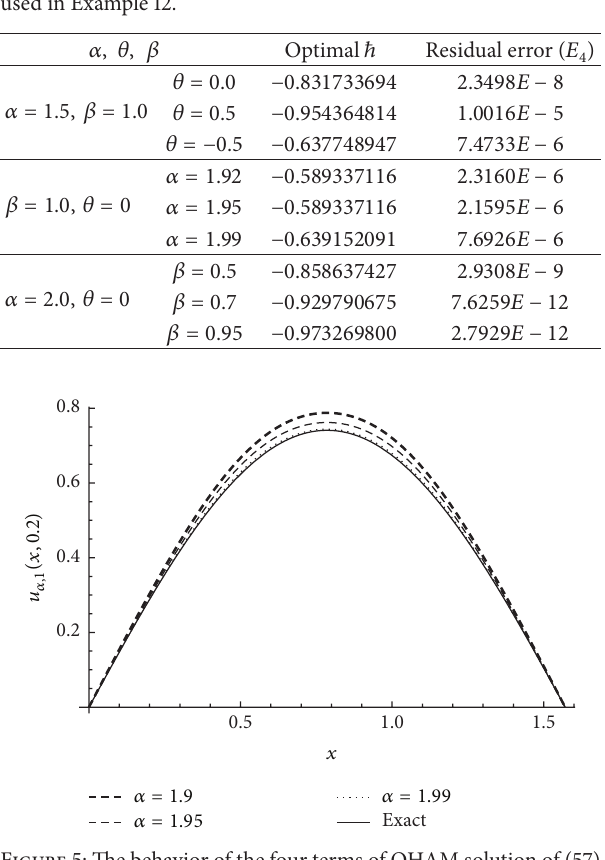
Figure 5: The behavior of the four terms of OHAM solution of (57) at 𝑡 = 0.2 , 0 < 𝑥 < 𝜋/2 , and the fractional parameters 𝜃 = 0 , 𝛽 = 1 , and 𝛼 = 1.5, 1.7, 1.9 , compared with the exact solution.